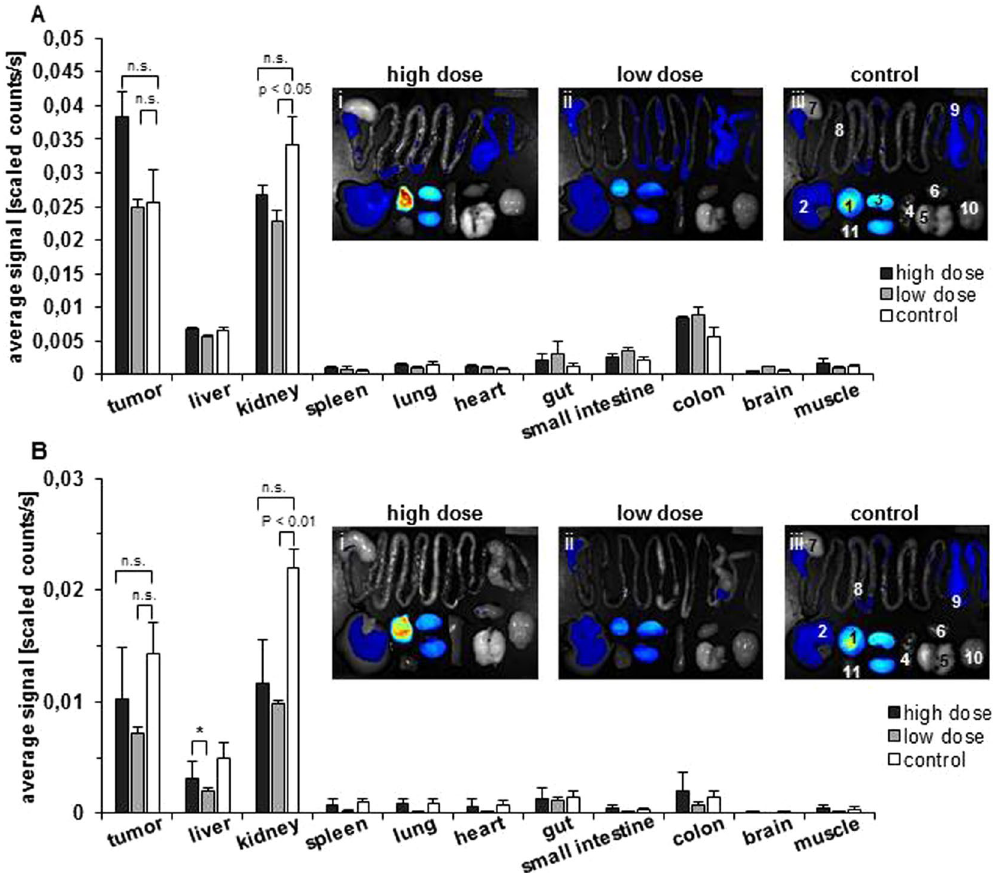
Figure 3. Biodistribution of the optical GRPR probe (BombesinRSense ™ 680) and optical α v β 3 integrin probe (IRDye ® 800CW RGD) at 8 days after hyperthermia treatment. ( A ) Semi-quantitative analysis of fluorescence intensities for GRPR in extracted mice organs after hyperthermia treatments. Macroscopic images with color- coded fluorescence intensities of the optical probe BombesinRSense ™ 680 (2 nmol) from each treatment group. i: after high dose hyperthermia, ii: after low dose hyperthermia and iii: in untreated control. ( B ) Semi- quantitative analysis of fluorescence intensities for α v β 3 integrin in extracted mice organs after hyperthermia treatments. Macroscopic images with color-coded fluorescence intensities of the optical probe IRDye ® 800CW RGD (1 nmol). i: after high dose hyperthermia, ii: after low dose hyperthermia and iii: in untreated control. Data represent the mean ± SEM of n = 5. (1 = tumor, 2 = liver, 3 = kidney, 4 = spleen, 5 = lung, 6 = heart, 7 = gut, 8 = small intestine, 9 = colon, 10 = brain, 11 = muscle), n.s.: not significant (p >